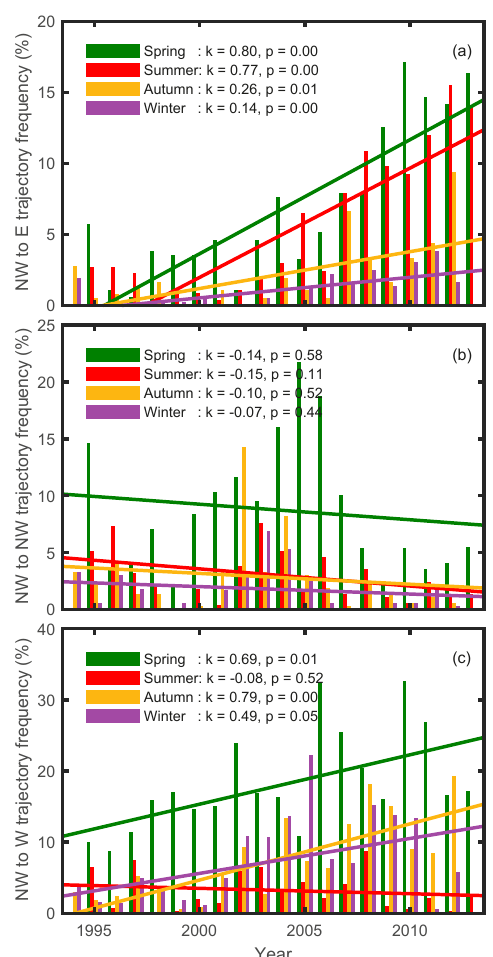
Figure 3. The occurrence frequency of trajectories whose average 168h direction is NW and 24h direction is E (a) , NW (b) , and W (c) in spring (green), summer (red), autumn (orange), and winter (pur- ple). Bars stand for the occurrence frequencies while lines are their corresponding linear